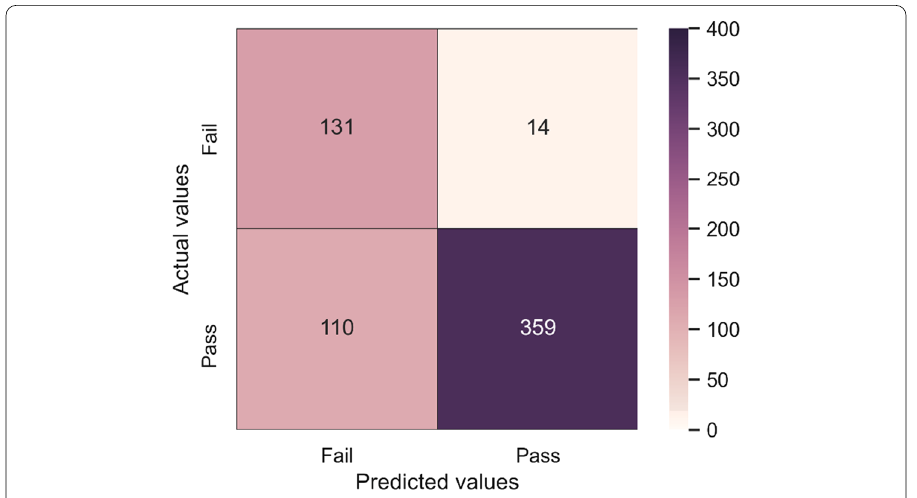
Fig. 4 Confusion matrix of the final ensemble model